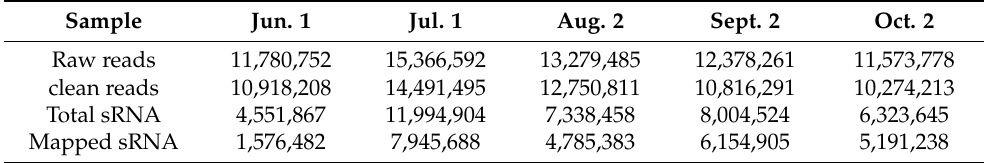
Table 1. Summary of small RNA sequencing from T. tuan seed.